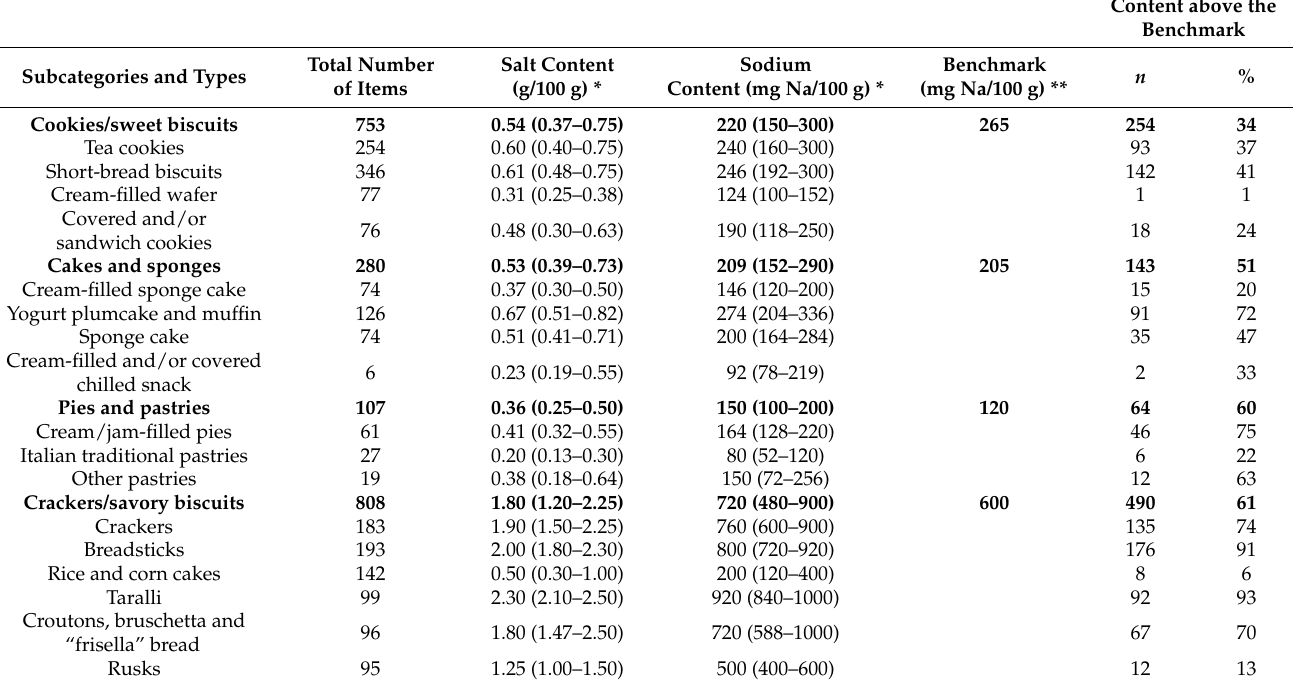
Table 1. Number of cereal-based products, in terms of subcategories and types, their salt and sodium content, the relative sodium benchmarks and the percentage of the items above the